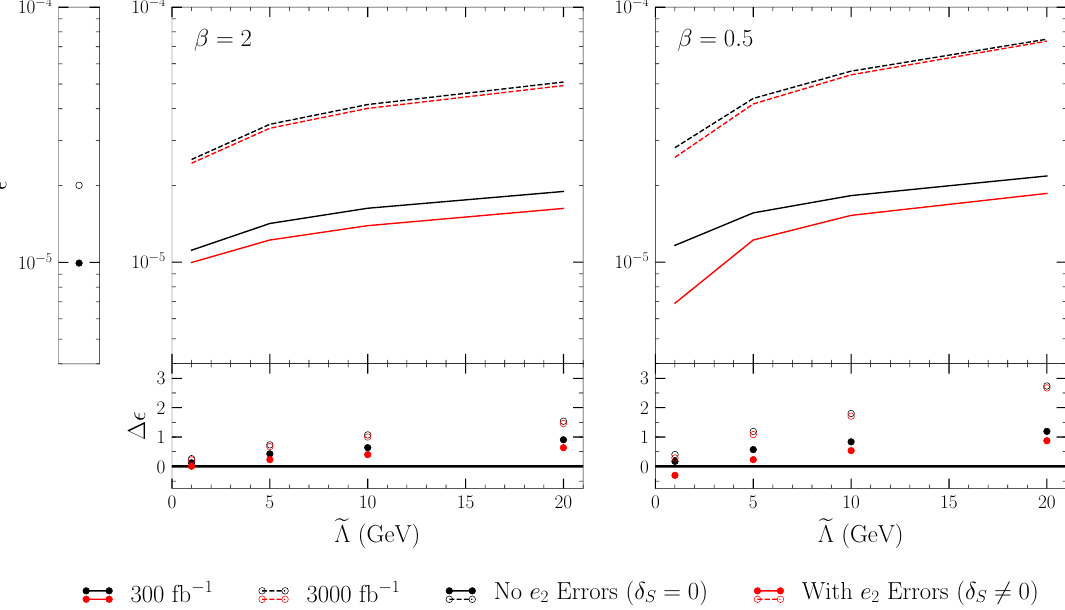
Figure 11 . The background reduction factor (see eq. (5.3)) required to observe new physics over the QCD background for p T = 1 TeV jets. We show the value required if there are no additional cuts made on jet substructure (assuming (cid:14) S = 0 ) [left]. Then we provide the results as a function of e (cid:3) taking (cid:12) = 2 [middle] and (cid:12) = 0 : 5 [right]. The resulting reduction in the needed (cid:15) as a result of the substructure cut is presented as a multiplicative factor below the middle and right plots. We vary the luminosity and provide results with and without errors, see the legend for